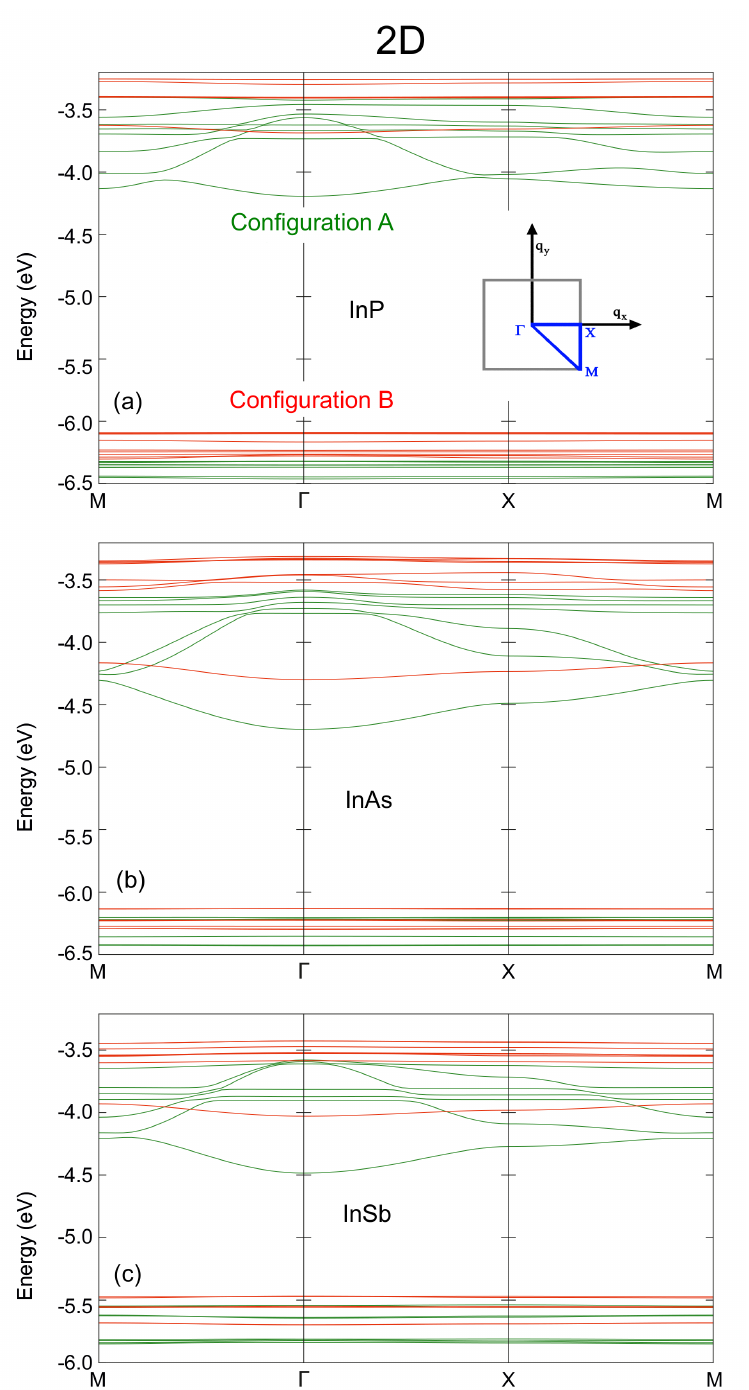
Figure 3. Miniband structure for 2D arrays of ( a ) InP, ( b ) InAs, and ( c ) InSb QDs with anion-rich (configuration A, green lines) and cation-rich (configuration B, red lines) surfaces. The energies on the vertical axis are relative to the vacuum level; the horizontal axis sweeps the Brillouin zone. The inset in ( a ) shows a schematic view of the path along the Brillouin zone together with the indexing of its major